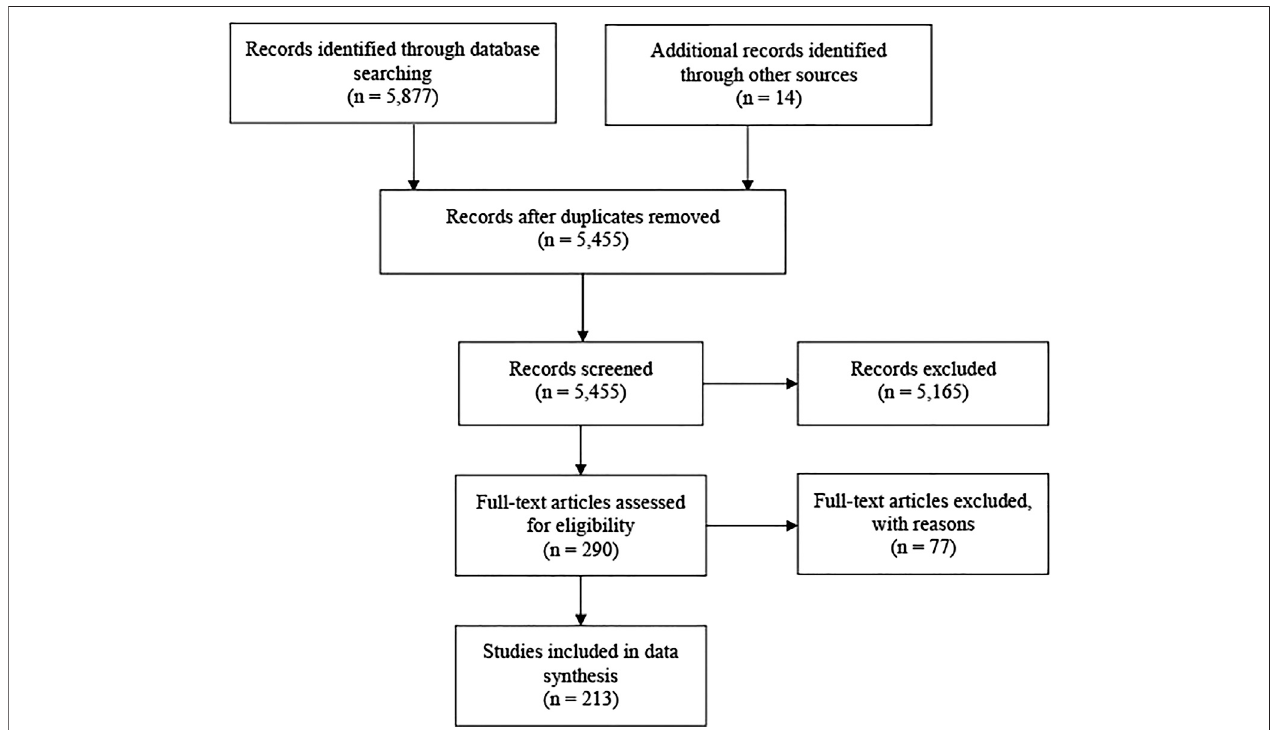
FIGURE 1 | Overview of data collection process for systematic